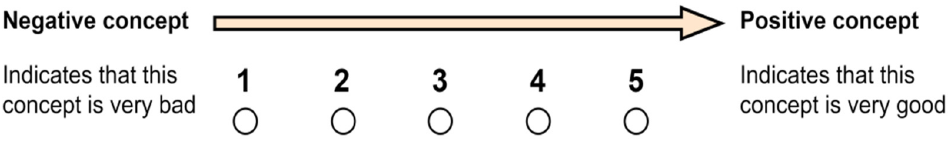
Figure 2. 5-point semantic difference